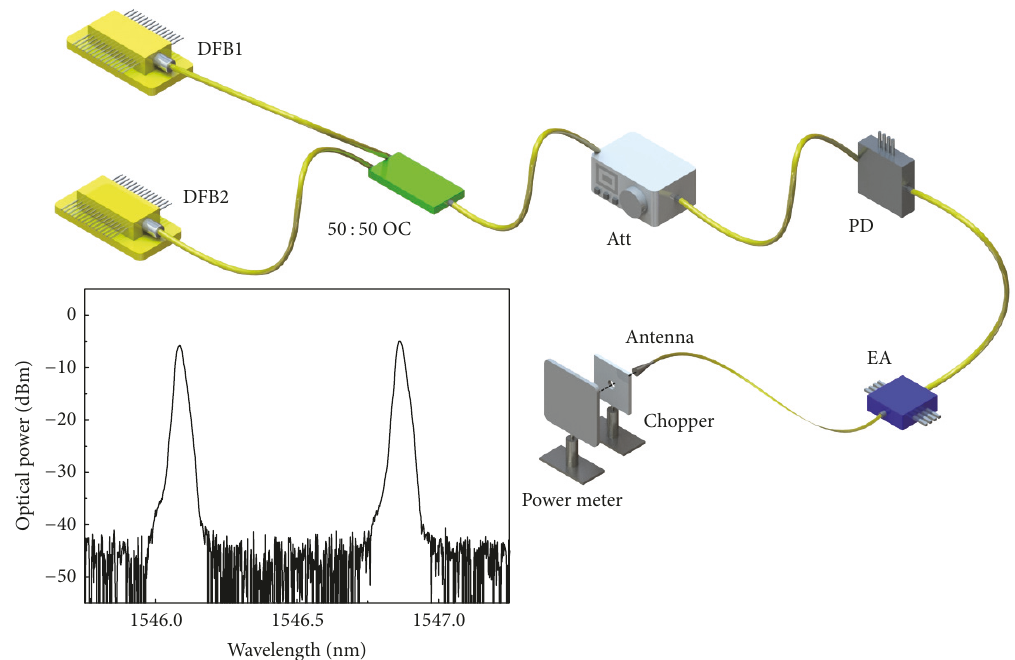
Figure 1: Schematic of the 0.1THz microwave generation system, and the insert is the optical spectrum of the source for optical heterodyne.